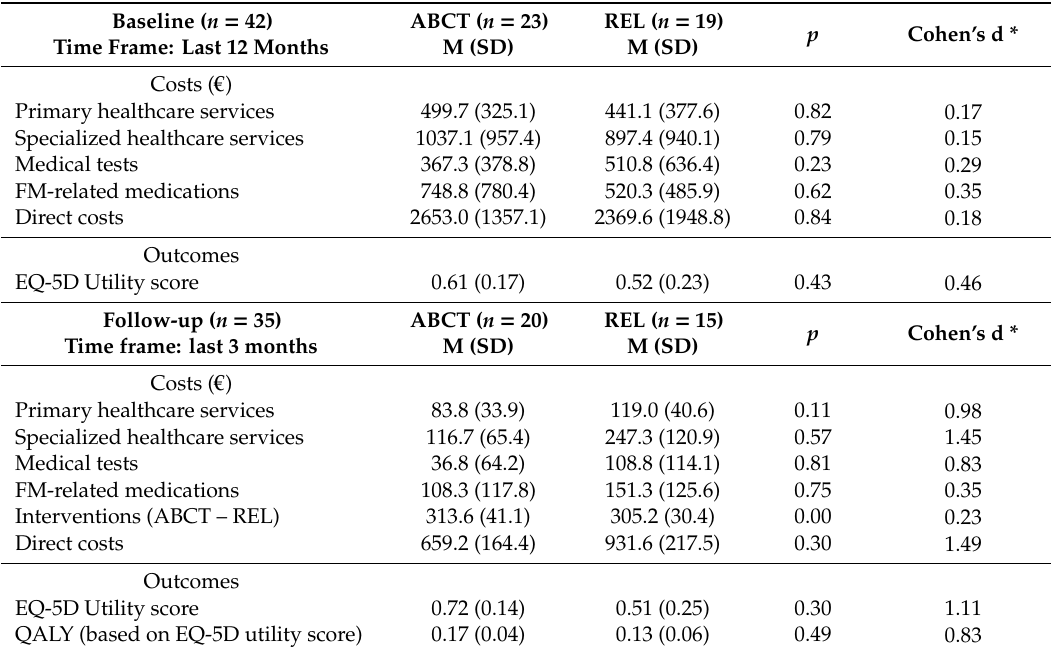
Table 3. Mean (SD) costs by cost category and treatment group (complete, unimputed cases).